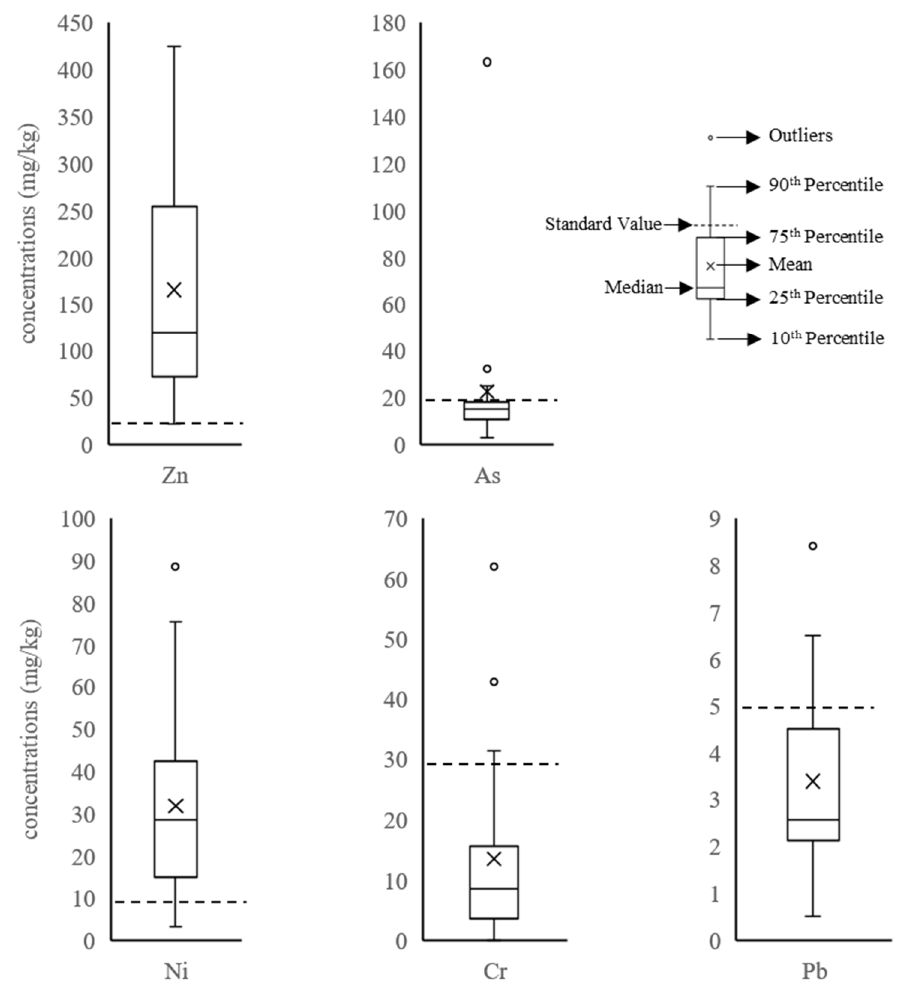
Figure 1. Boxplots of the heavy metal concentrations (mg/kg) for the recycled products.